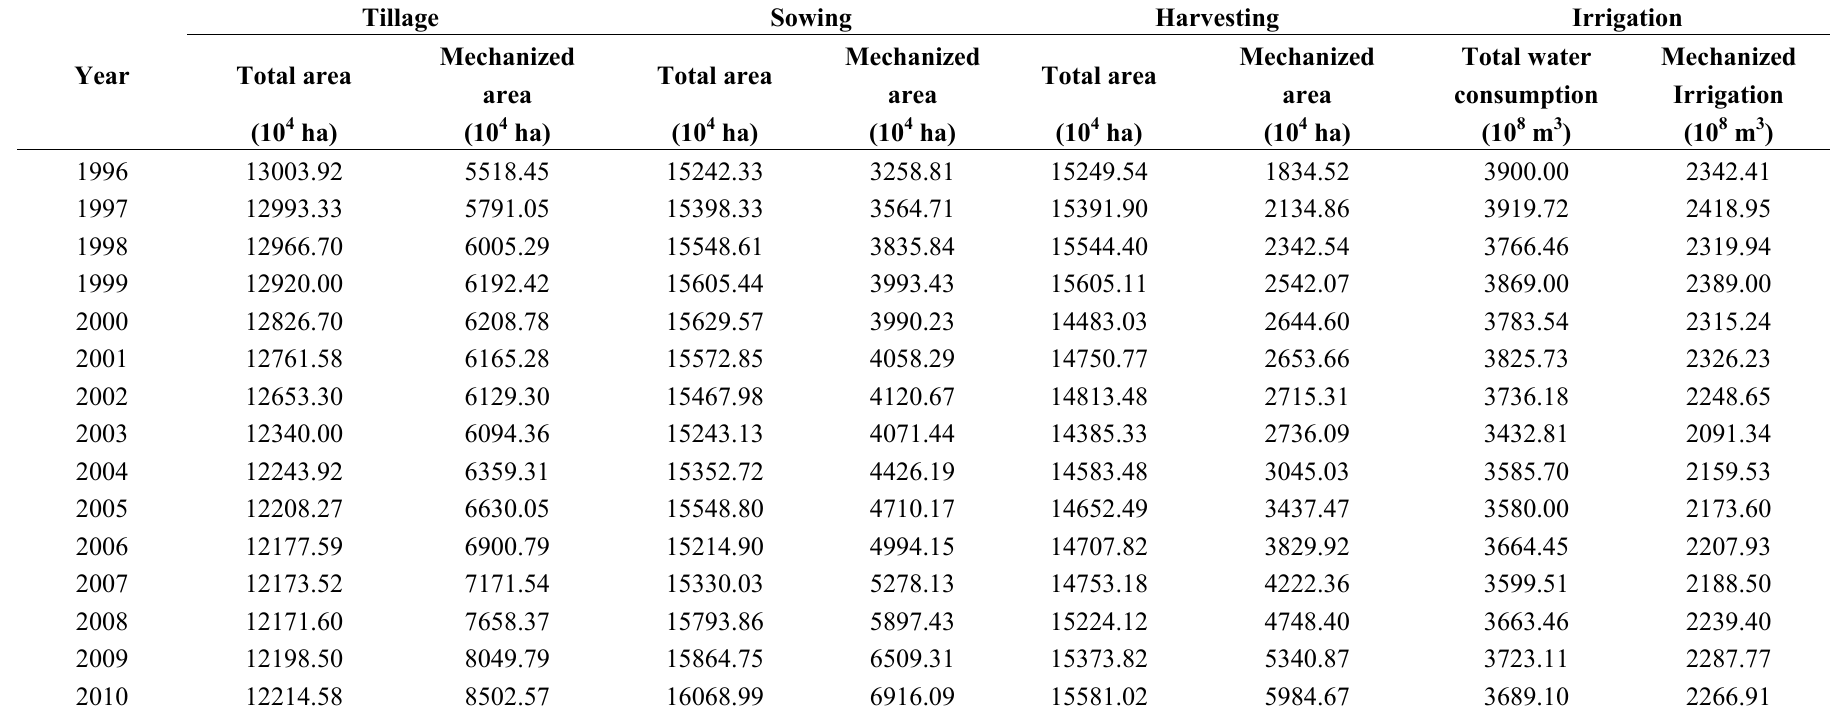
Table A1. Workload statistics of the four